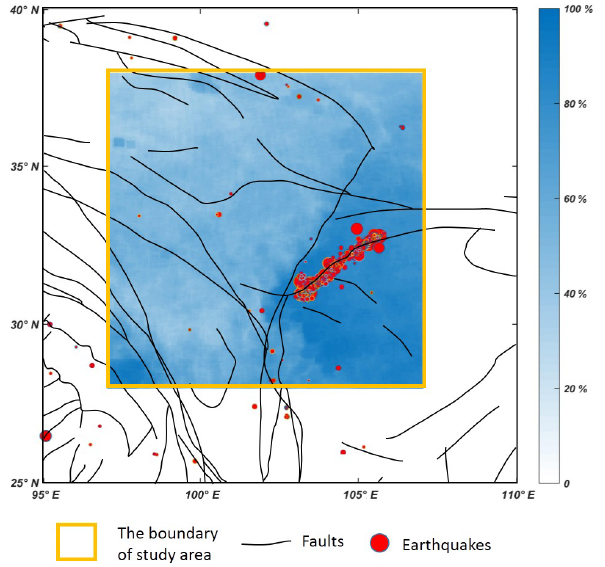
Figure 7. The distribution of earthquakes and the frequency of each pixel blocked by cloud cover in period C; higher values indicate that the pixels are more frequently blocked by